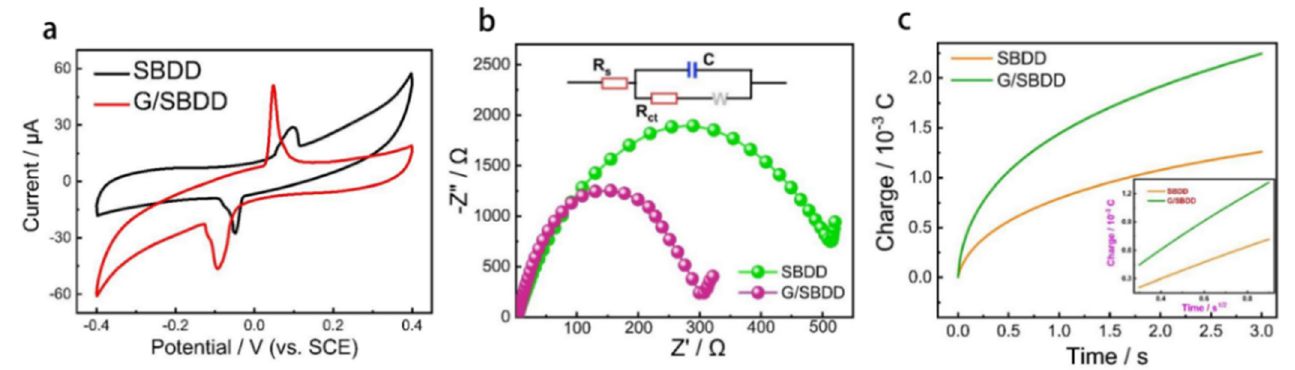
Figure 9. Characterization results of the sensing performance of G/SBDD and SBDD. ( a ) CV curves of SBDD and G/SBDD electrodes in 0.1 M Na 2 SO 4 solution containing 5 ppm Pb 2+ with a scan rate of 10 mV/s; ( b ) Nyquist plots of SBDD and G/SBDD electrodes in 0.1 M Na 2 SO 4 solution containing 5 ppm Pb 2+ with a frequency range of 10 − 2 to 10 5 Hz; insets are equivalent circuit diagram; ( c ) Q-t curves of SBDD and G/SBDD electrodes in 0.1 M Na 2 SO 4 solutions containing K 3 [Fe (CN) 6 ]; inset shows linear partial charge (Q) as a function of t 1/2 .